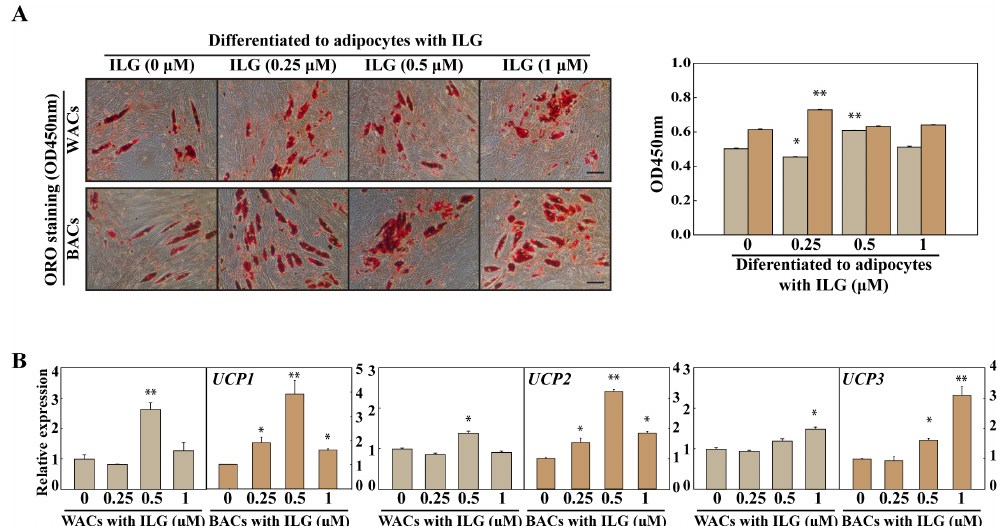
Figure 2 . Effects of low-dose ILG on the white-to-beige transdifferentiation of hASCs. ( A ) Representative microscopic images of adipocytes stained with Oil Red O (Scale bar = 200 μ m). OD values measured from isopropanol elution of Oil Red O stain after 12 days of differentiation. ( B ) Effect of ILG treatment on the mRNA expression of UCP in white adipocytes (WACs) and brown adipocytes (BACs). Gene expression in cells treated with ILG for 24 h after adipogenic differentiation was analyzed by real-time PCR. GAPDH was used as an internal control to normalize the expression of the target genes; n = 3 independent experiments; * p < 0.05 and ** p < 0.01.